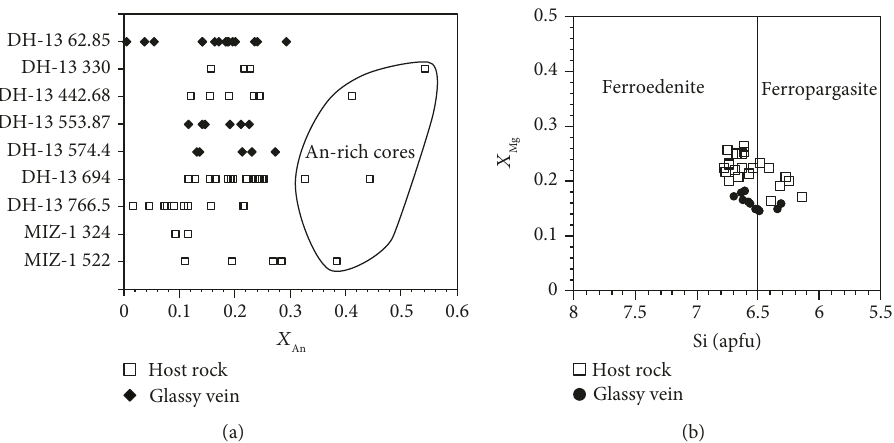
Figure 5: Chemical compositions of plagioclase and amphibole. (a) Ratio of anorthite composition in plagioclase ( X and MIZ-1). Each value on the right of the borehole code indicates the sampling depth. (b) Si apfu and X squares: host rock; solid circles: glassy veins.